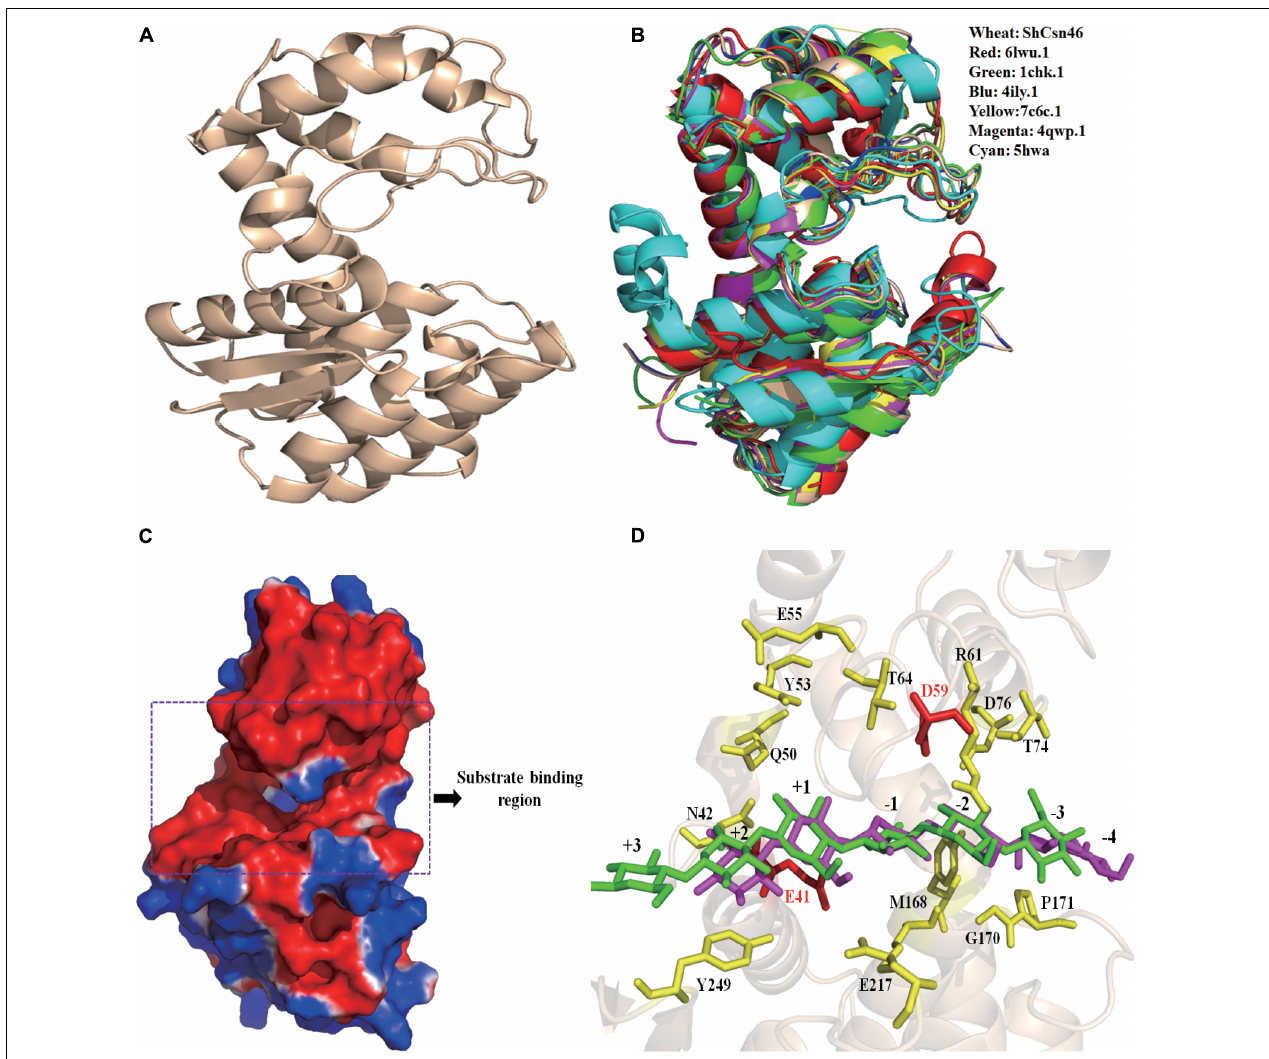
FIGURE 2 | Homology-modeling structure of Sh Csn46. The overall structure of Sh Csn46 (A) . Structural alignment of Sh Csn46 with previously reported GH46 family chitosanases (B) . 4ily.1, 1chk.1, 4qwp.1, 6lwu.1, 5hwa, and 7c6c represent the tertiary structure of chitosanases from Streptomyces sp. SirexAA-E, Streptomyces sp. N174, Microbacterium sp., Gynuella sunshinyii YC6258, Bacillus circulans MH-K1, and Bacillus subtilis MY002, respectively. Surface electrostatic potential of Sh Csn46 (C) . The surface coloring is based on the electrostatic potential with a gradient from red (electronegative) to blue (electropositive). Interactions